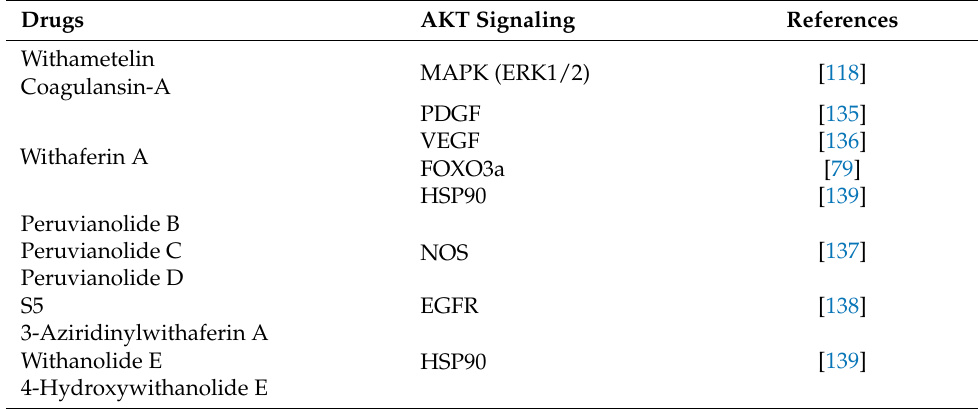
Table 4. Withanolides that can regulate the AKT signaling pathway.